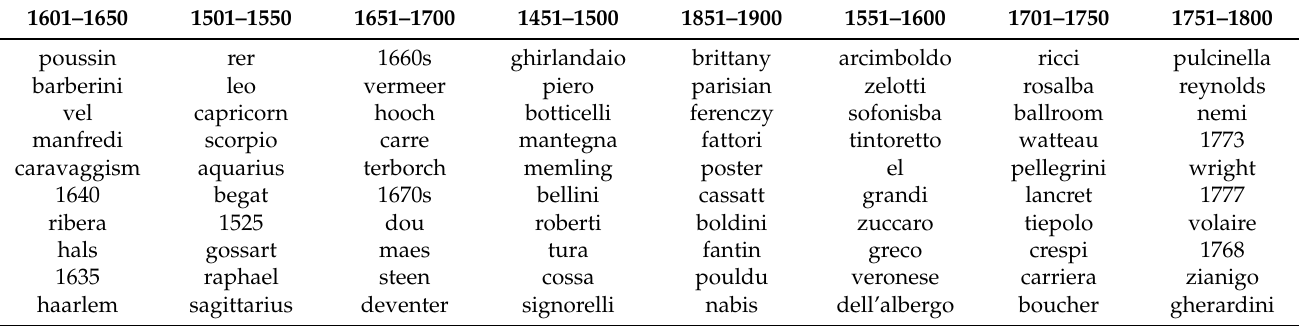
Table 5. Words with highest values for several classes using second-layer construction. We show top 10 words for each class. (Artists classified by timeframe from